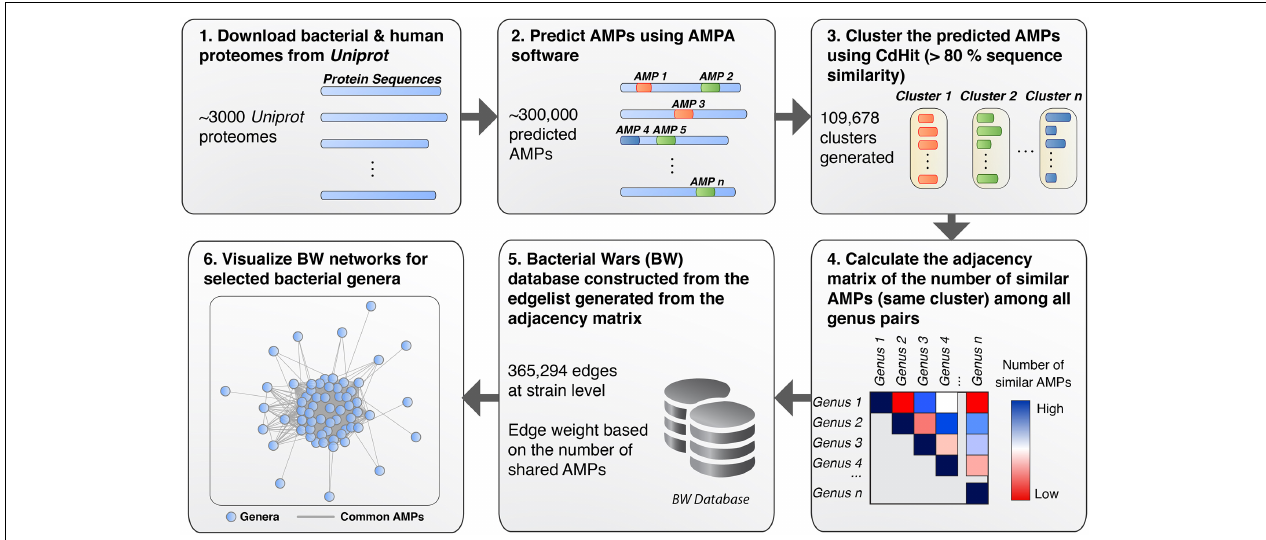
FIGURE 2 | Schematic workflow of the BW methodology. (1) All bacterial proteomes were retrieved from UniProt and filtered to extract the Swiss-Prot curated sequences. (2) AMP perdition was performed using AMPA . (3) CdHit was used to cluster AMPs based on sequence similarity (threshold > 80%). (4) Pairwise comparison was performed for all bacterial taxa to obtain the number of common AMPs for each bacterial pair (i.e., creating an adjacency matrix). (5) The adjacency matrix was used to construct an edge list, which, was used to create the BW database of interactions. (6) Querying the BW database for selected taxa allows for networks of interactions to be generated where bacteria taxa are represented as nodes and the number of common peptides as the edge